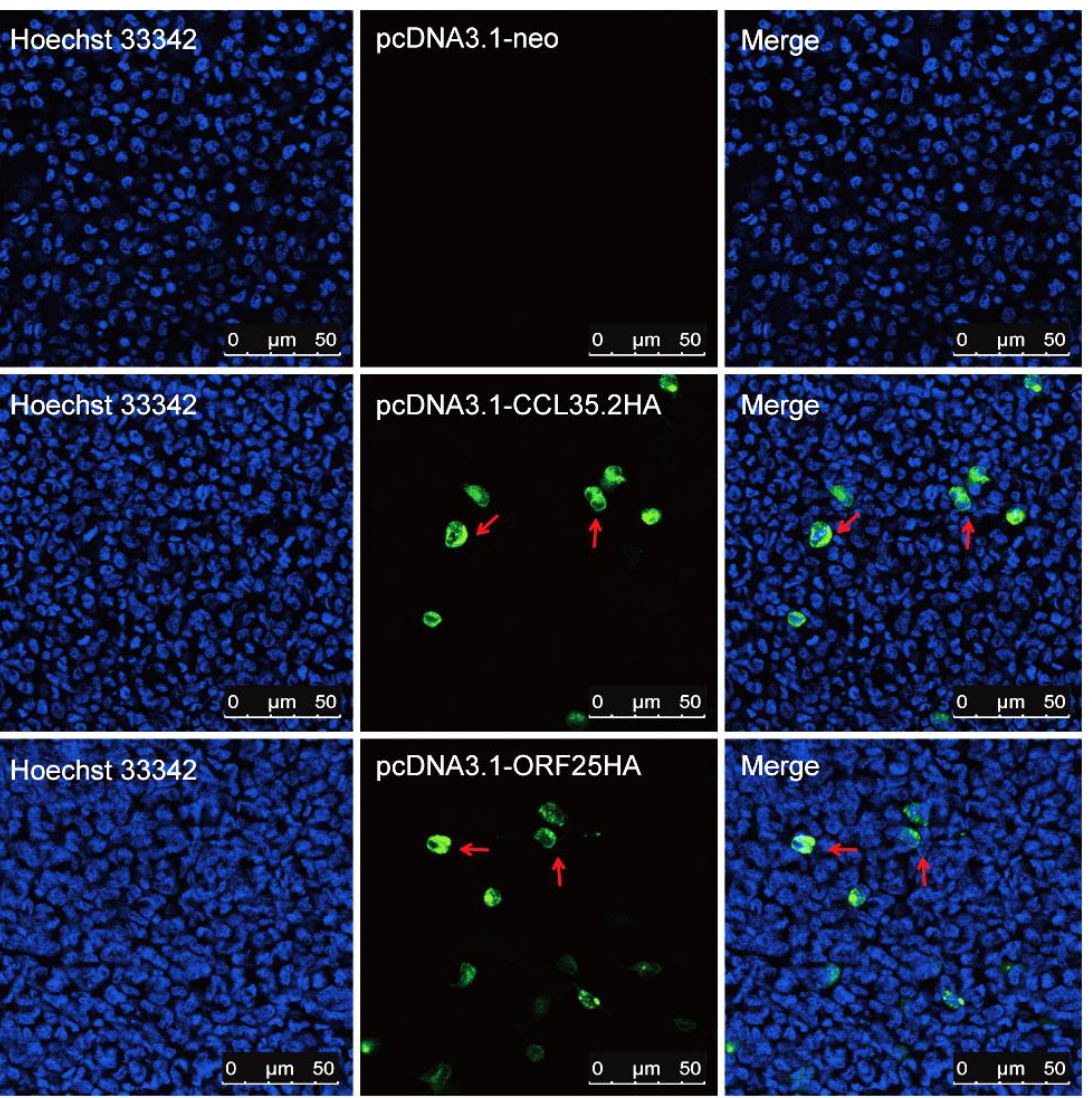
Figure 1. Detection of CCL35.2HA and ORF25HA protein in vitro. FHM cells were transfected with pcDNA3.1-neo, pcCCL35.2 and pcORF25, respectively. IFAs were performed with mouse anti-HA antibody and goat anti-mouse IgG-FITC (green) second antibody. Cell nuclei were stained by DAPI (blue). The red arrow indicates the specific green fluorescence produced by indirect immunoassay.